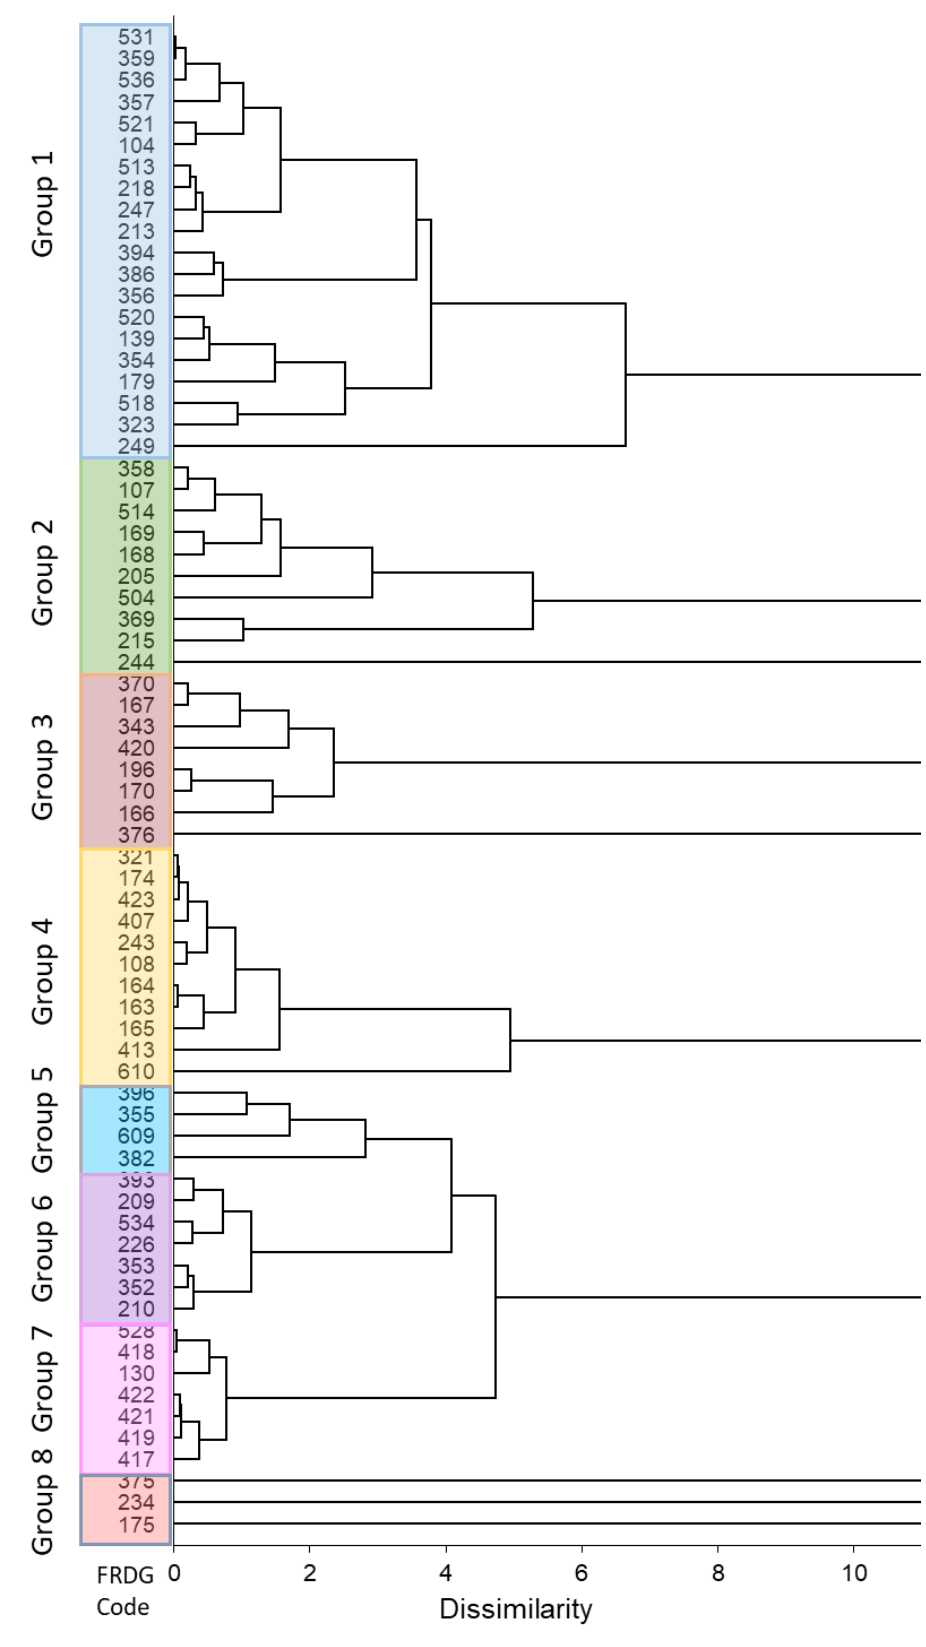
Figure 4. Dendrogram resulting from the unsupervised agglomerative hierarchical clustering distinguishing eight main groups of groundwater bodies.